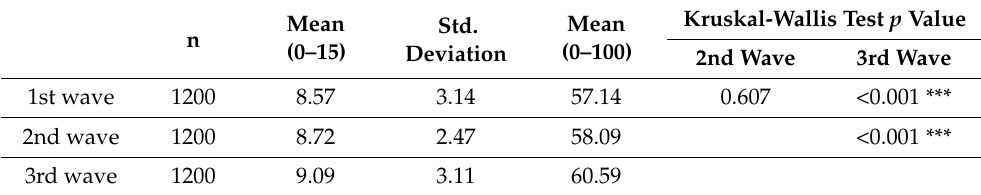
Table 2. Subjective psychological well-being of Hungarian population (18–69 years). n